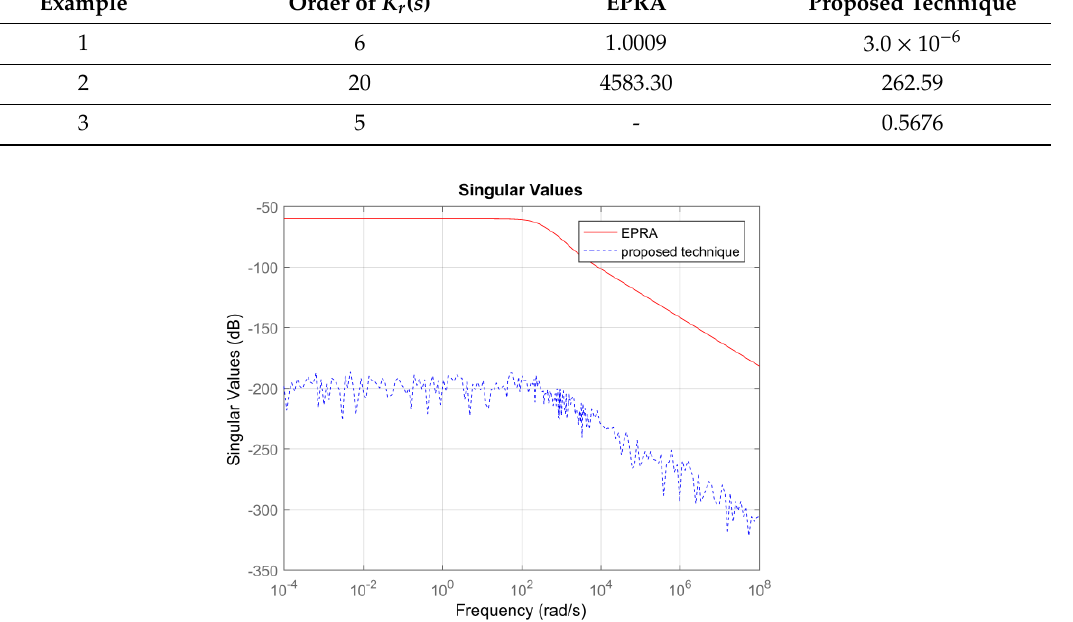
Figure 3. Sigma plot of the weighted error W ̅̅̅ 𝑜 (𝑠)[𝑃(𝑠) − 𝑃 𝑟 (𝑠)] .